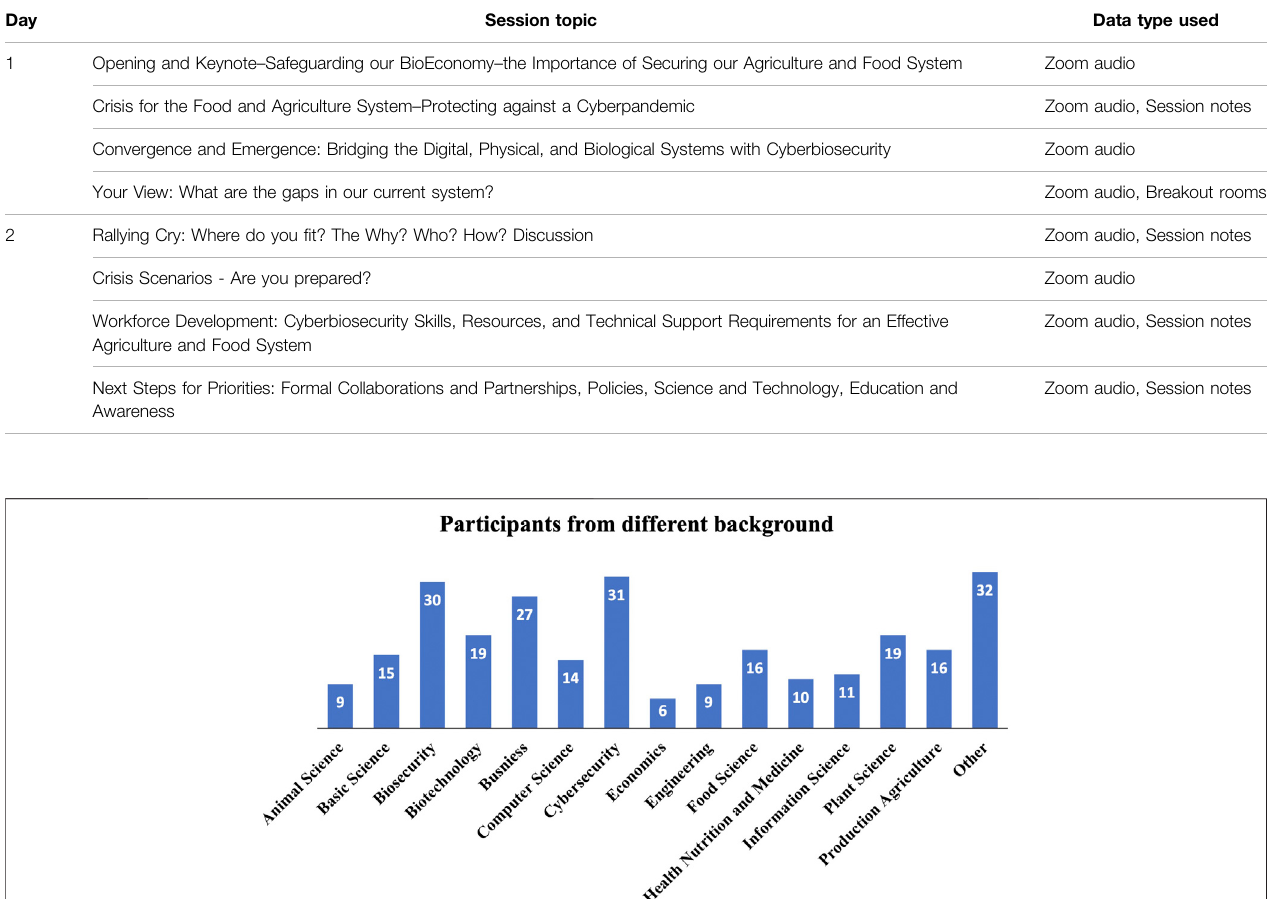
TABLE 1 | Session agenda for the Securing Agriculture and Food Economy (SAFE) with Cyberbiosecurity virtual workshop (October 6 – 7, 2020) and data type used for analyses.